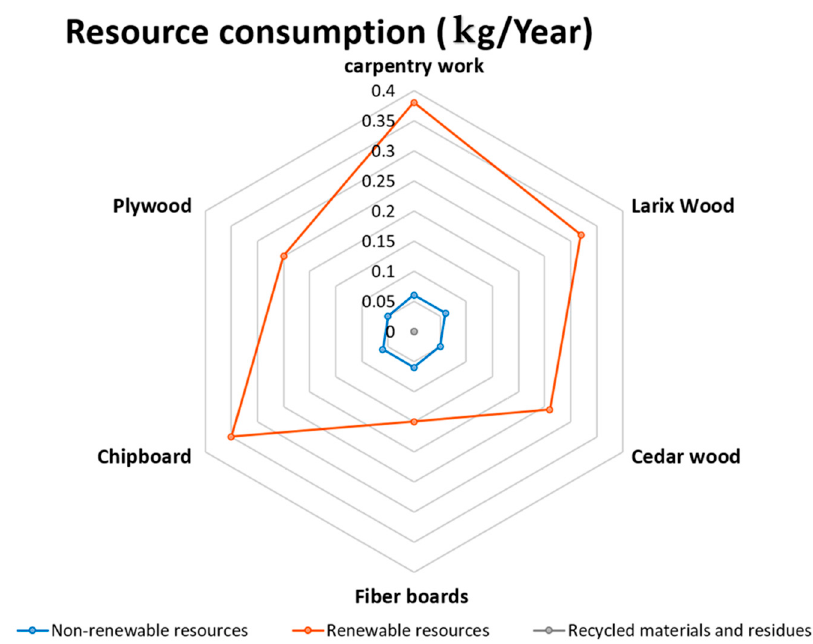
Figure 4. The impact of resource consumption on the selected façade wooden material environmen- tal [68–72].